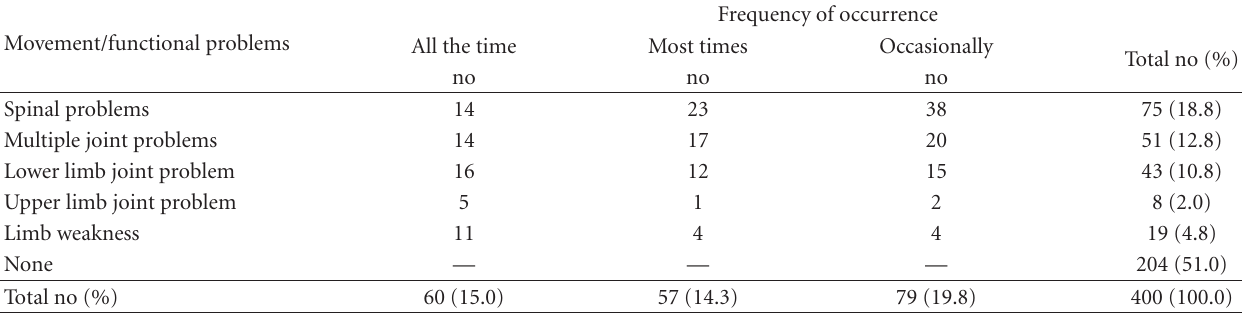
Table 2: Household respondent’s movement/functional problems and frequency of occurrence.